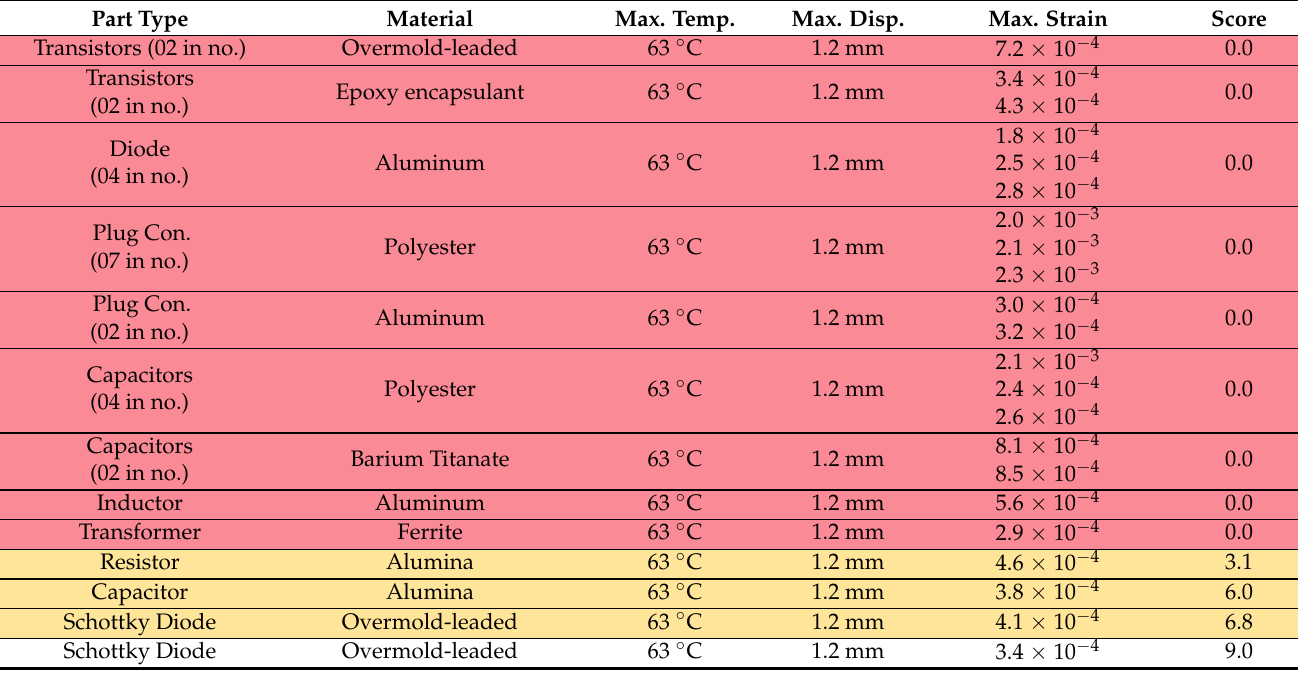
Table 3. The state of PCB components subjected to thermal mechanical